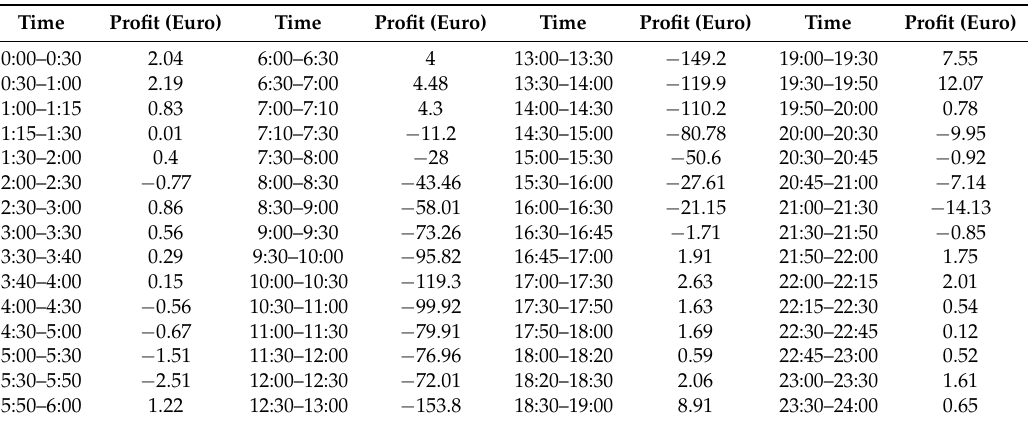
Table 2. Maximum profit of the CHP in real time.